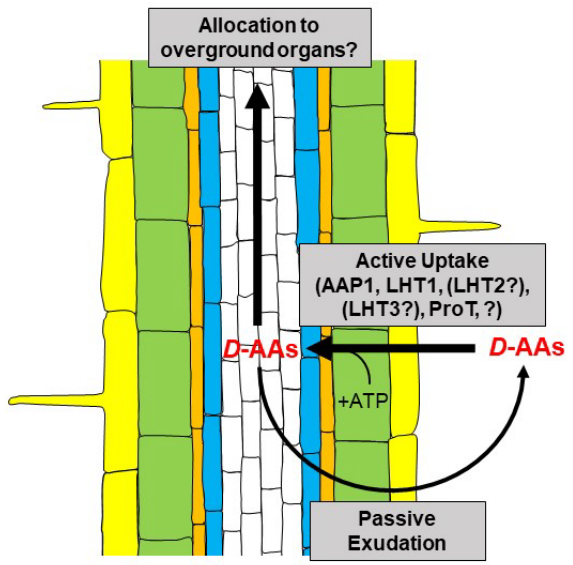
Figure 1. Ways of d -AA allocation in the Figure 1. Ways of D -AA allocation in the root.